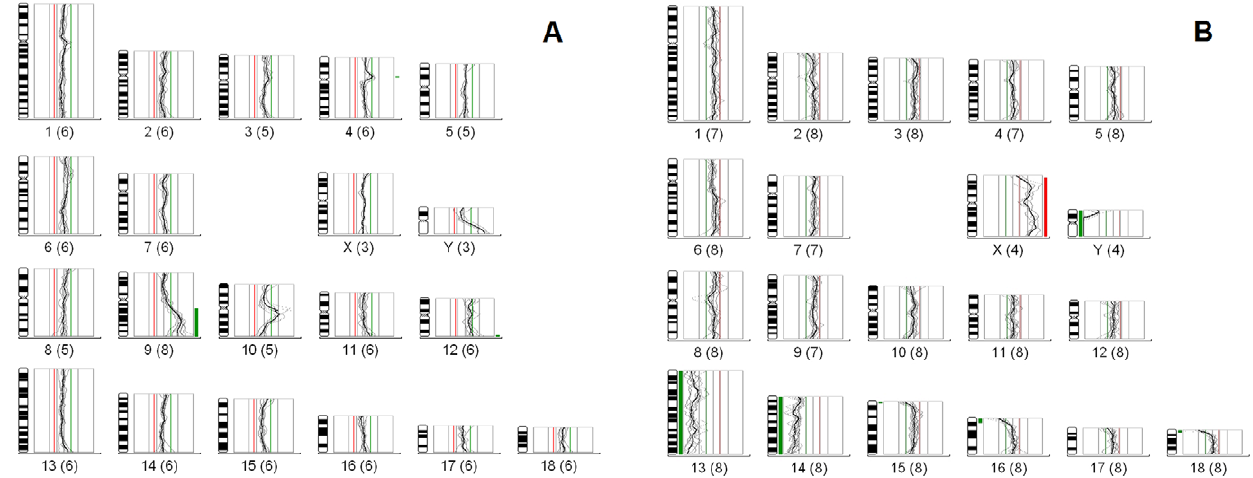
Figure 1. The example of WGA-CGH analysis of 2 aneuploid pig embryos. (A) the male embryo detected with partial loss of chromosome 9q; (B) the female embryo detected with loss of chromosomes 13 and 14. Amplified DNA obtained from the embryo was labelled with red fluorescence and amplified reference male porcine DNA was labeled with green fluorescence. Both DNA samples were mixed and allowed to hybridize to male porcine mitoses. Subsequently, the red and green fluorescence was captured and analyzed using dedicated CGH software. The heterochromatin regions (e.g. centromeres and the q arm of chromosome Y) were excluded from the analysis due to the abundance of repetitive DNA sequences.